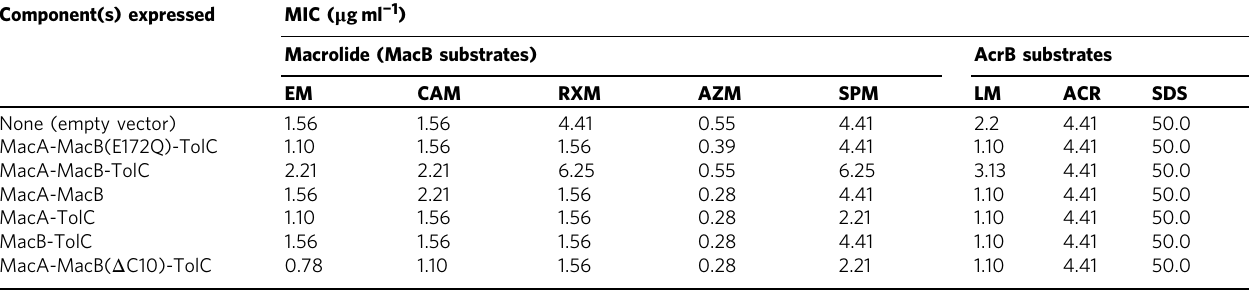
Table 1 Measurement of drug resistance of E. coli expressing A. baumannii MacA-MacB-TolC or transport inactive mutants Component(s) expressed